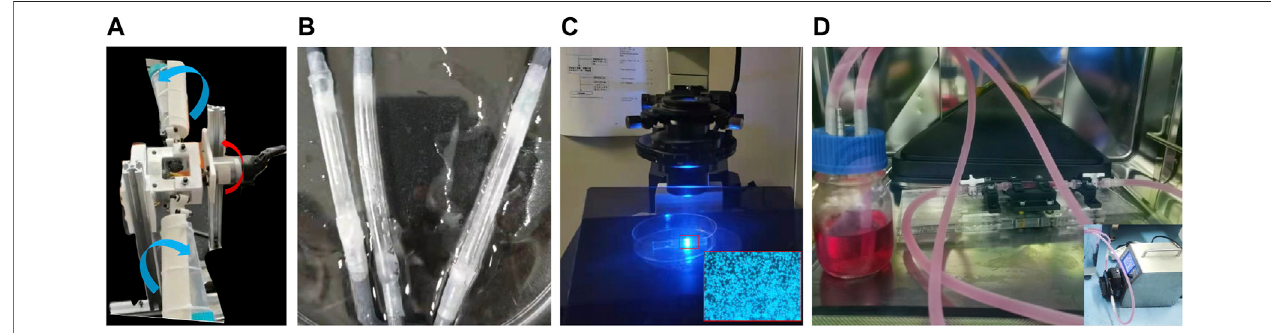
FIGURE 2 | Biaxial rotating mechanism (A) , the endothelialized vascular model (B) and its observation under the inverted microscope (C) , and the device used for perfusion cell culture (D)